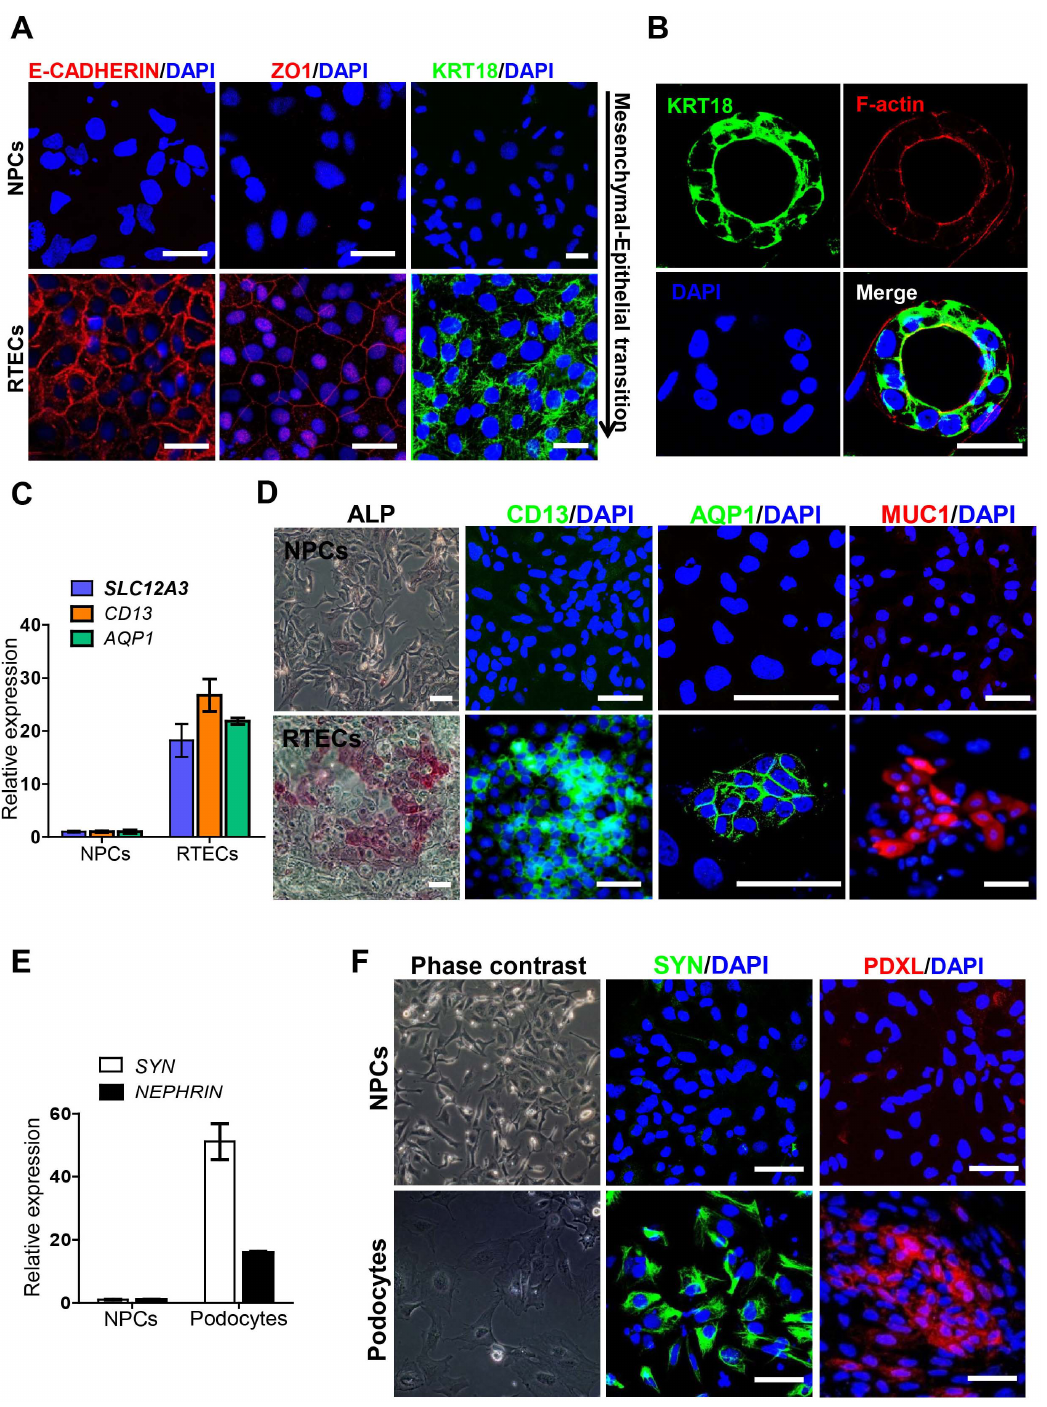
Figure 6. Differentiation potential of hESC-derived NPCs into fully differentiated cells within nephrons. A. Expression of epithelial markers such as E-CADHERIN, ZO1 and KRT18 in hESC-derived renal tubular epithelial cells (RTECs) compared with un-induced NPCs in immunocytochemistry, representing mesenchymal-epithelial transition. Scale bars=50 m m. B. In vitro tubulogenesis of hESC-derived NPCs, cultured as three dimensional system mixed with collagen type I in renal epithelial cells growth medium (REGM TM ) for 21 days, which were analyzed by immunofluorescence with an epithelial marker KRT18 (green) and F-actin (red) for showing apicobasal polarization of RTECs in tubular structures. Scale bars=50 m m. C. Transcriptional expression of RTEC-specific genes ( SLC12A3 , CD13 and AQP1 ) was examined by real time RT-PCR. Relative expression levels were normalized to GAPDH, and the bars show mean 6 S.E.M (n=3). D. Expression of proximal renal tubular markers (ALP, alkaline phosphatase; AQP1, aquaporin1; CD13) and distal renal tubular marker MUC1 in hESC-derived RTECs compared with un-induced NPCs in immunocytochemistry. Scale bars=100 m m. E. Transcriptional expression of podocyte-specific genes ( SYN and NEPHRIN ) was evaluated by real time RT-PCR. Relative expression levels were normalized to GAPDH, and the bars show mean 6 S.E.M (n=3). F. Phase contrast image and immunocytochemistry of podocyte-specific markers such as SYN (green) and PDXL (red) in hESC-derived glomerular podocytes compared with un-induced NPCs. Scale bars=100 m m. doi:10.1371/journal.pone.0094888.g006 PLOS ONE |